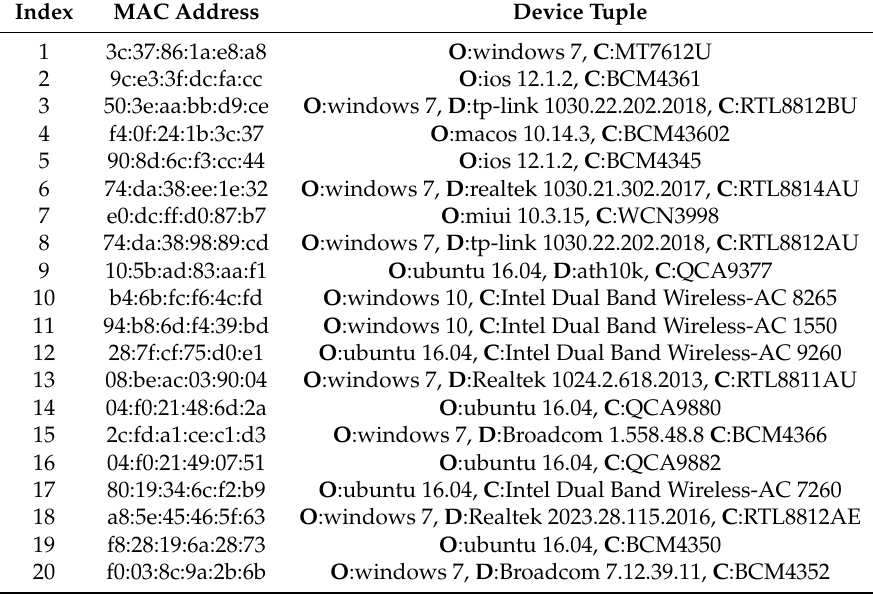
Table 2. List of 80211ac device